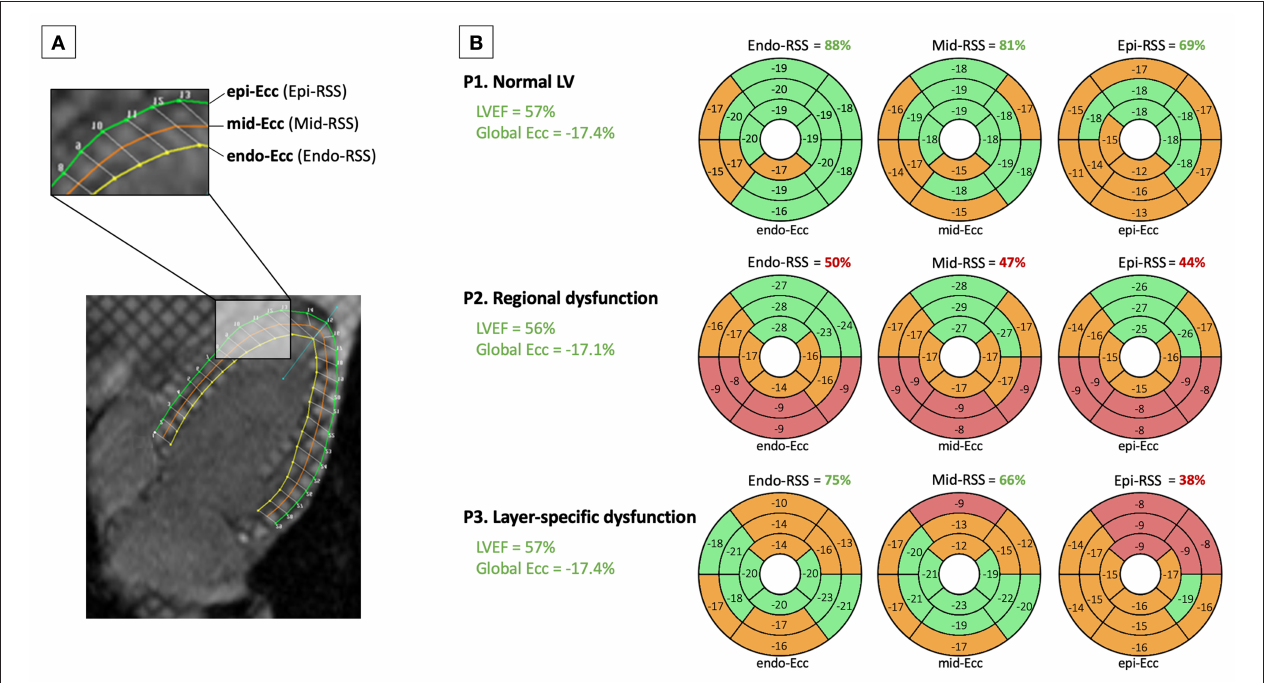
FIGURE 2 | Schematic comparison of variations in the RSS used in different subclinical pathophysiological settings. (A) Illustrates the method used to assess global, regional, and layer-specific Ecc using short-axis tagged magnetic resonance images. Grid lines (tags) are visible, and contours drawn at three myocardial levels [green [epicardial], orange [mid-myocardial], and yellow [endocardial]] allow tracking of myocardial motion and Ecc. Endo-RSS, Mid-RSS, and Epi-RSS were defined using endo-Ecc, mid-Ecc, and epi-Ecc for the 16-segment model, respectively, as three indexes expressed as a percentage of good LV regional function. (B) Shows three patients from this cohort who had the same normal LVEF value (57%) and global Ecc ( − 17%). Patient 1 (P1) had a normal regional Ecc, assessed using Mid-RSS as a score of the mid-Ecc (81%). Patient 2 (P2) had a normal global Ecc ( − 17.1%); however, he had a regional dysfunction defined by an altered regional Ecc, with all three RSS < 50%. Patient 3 (P3) had normal Endo-RSS (75%) and Mid-RSS (66%); however, he had a layer-specific dysfunction defined by a reduced Epi-RSS < 50%. These three patients had different RSS values and significantly different risk levels of cardiovascular events that were not detected when using the LVEF or global